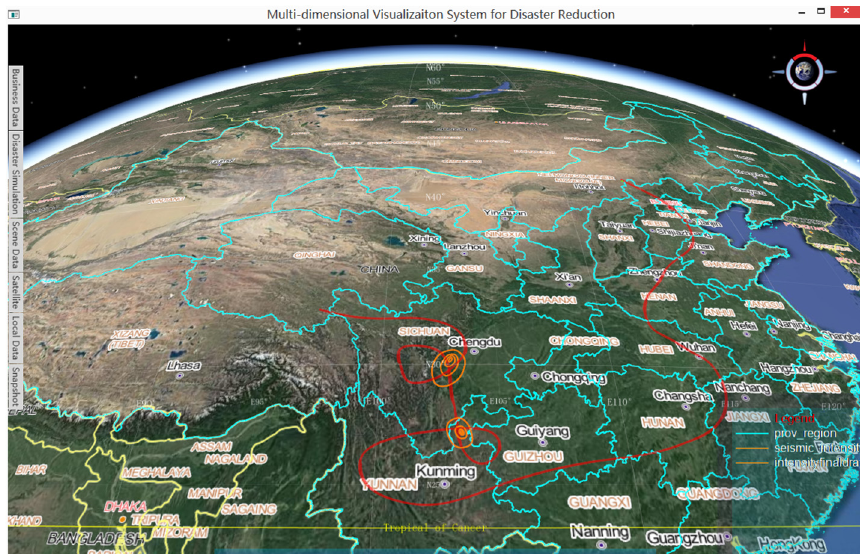
Figure 9. Diagram of the viewpoint flight path.